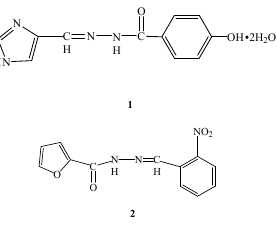
Figure 1. The scheme of the hydrazone compounds ( 1 and 2 ) .